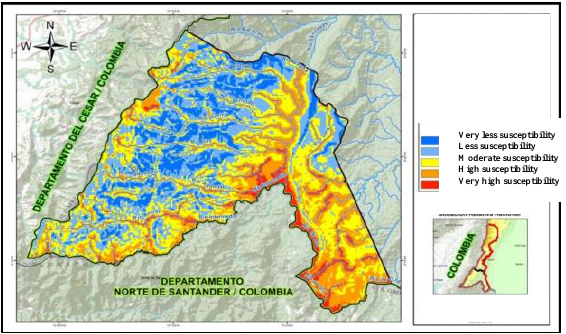
Figure 10. Map of susceptibility to the planting of illicit crops